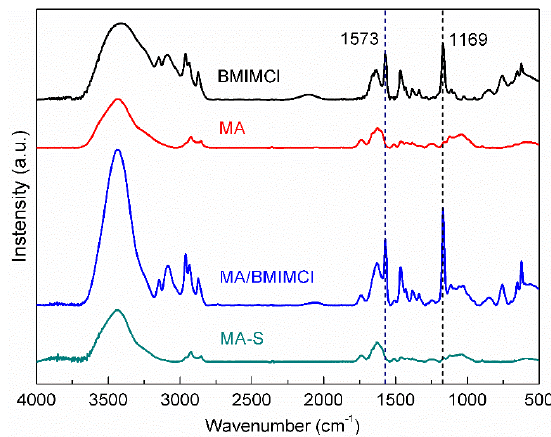
Figure 2. FTIR spectra of 1-butyl-3-methylimidazolium chloride (BMIMCl), manchurian ash (MA), MA impregnated with BMIMCl (MA/BMIMCl) and Soxhlet-extracted MA (MA-S).